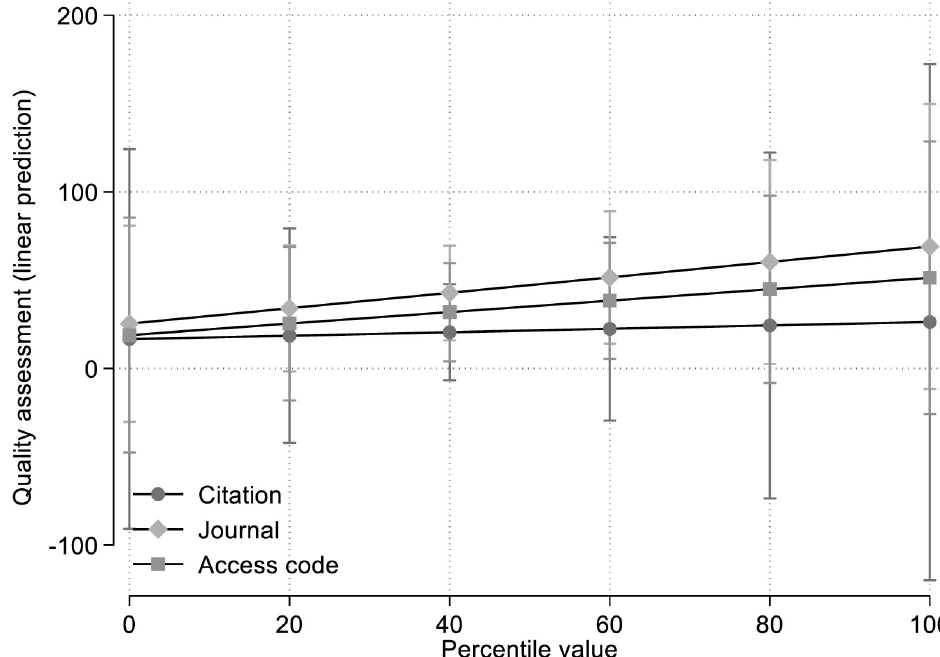
Fig 2. Relationships between treatments (citation, journal, and access code) and quality assessment.